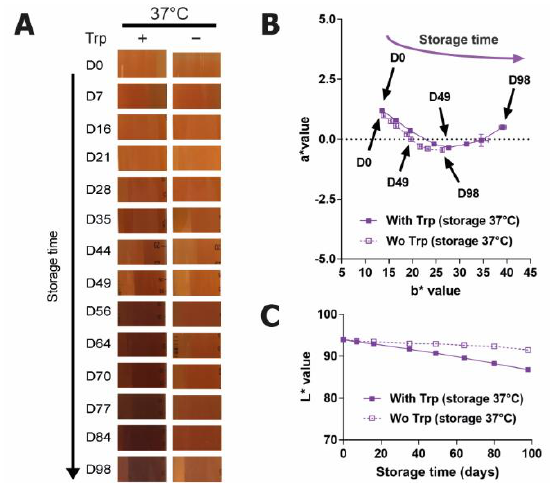
Figure 2. Stability study of the feed with or without (wo) Trp at 37 °C over 98 days. ( A ) Images of the solutions. ( B ) Changes in a*/b* and ( C ) L* values in the solutions.